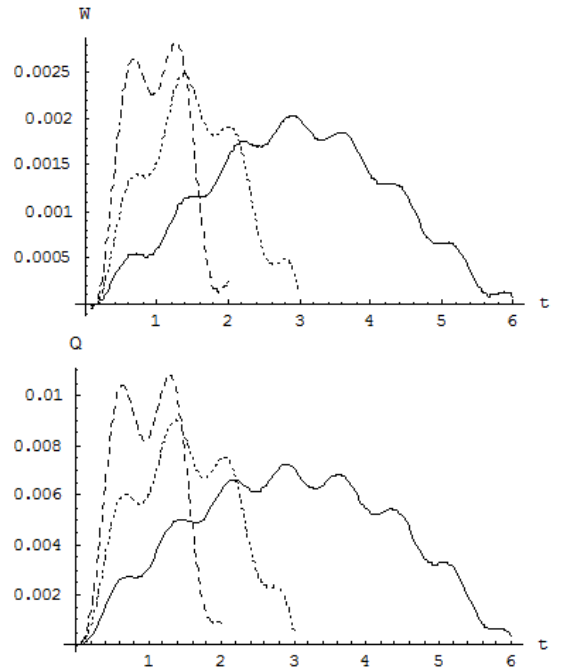
Figure 9: The influence of the speed for R = 50 m, e H = 3 m, e V = 1.20 m, and υ = 10 m/s ( ___ ), υ = 20 m/s (......), υ = 30 m/s ( - - - ).